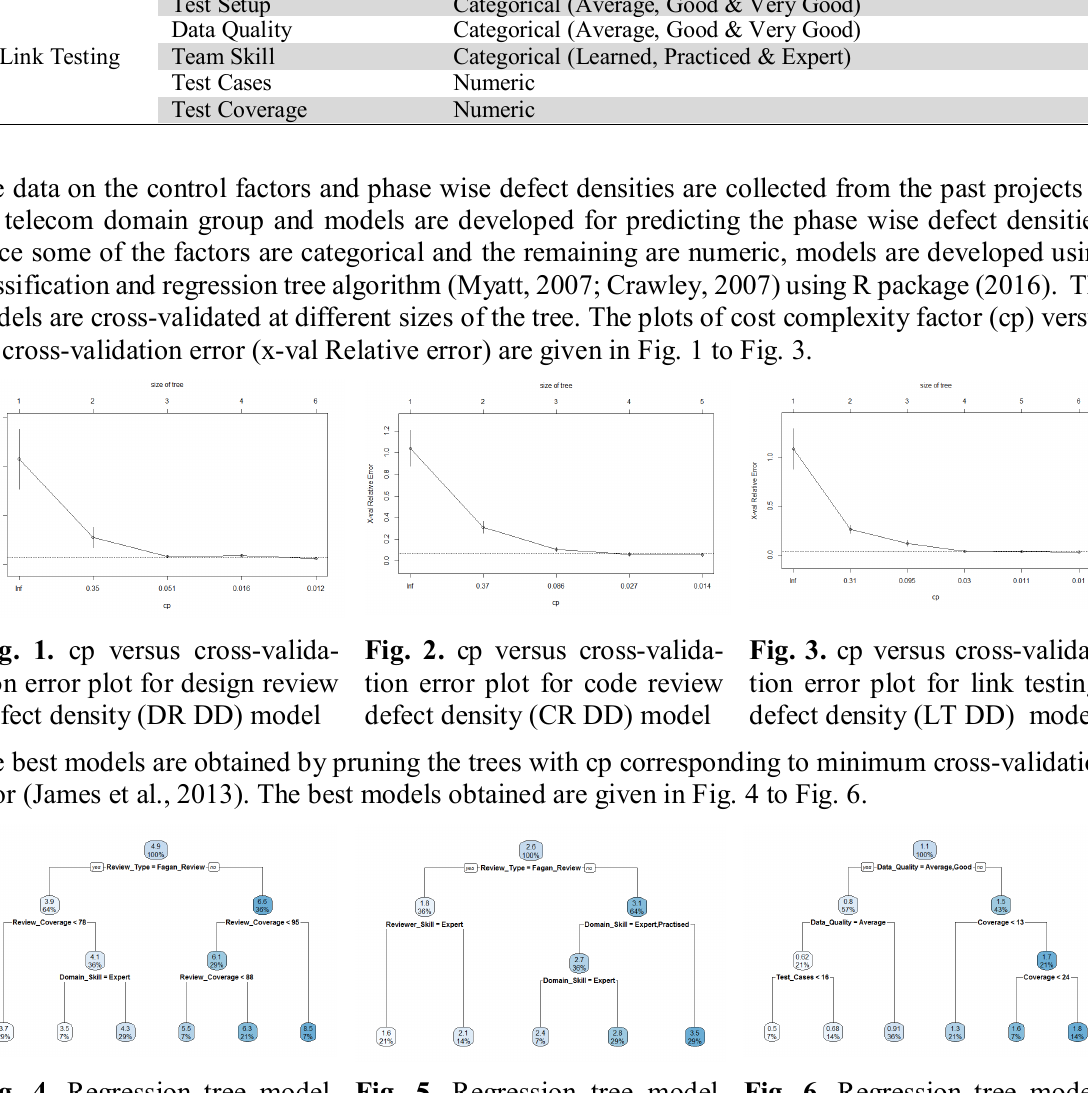
Fig. 6. Regression tree model for link testing defect